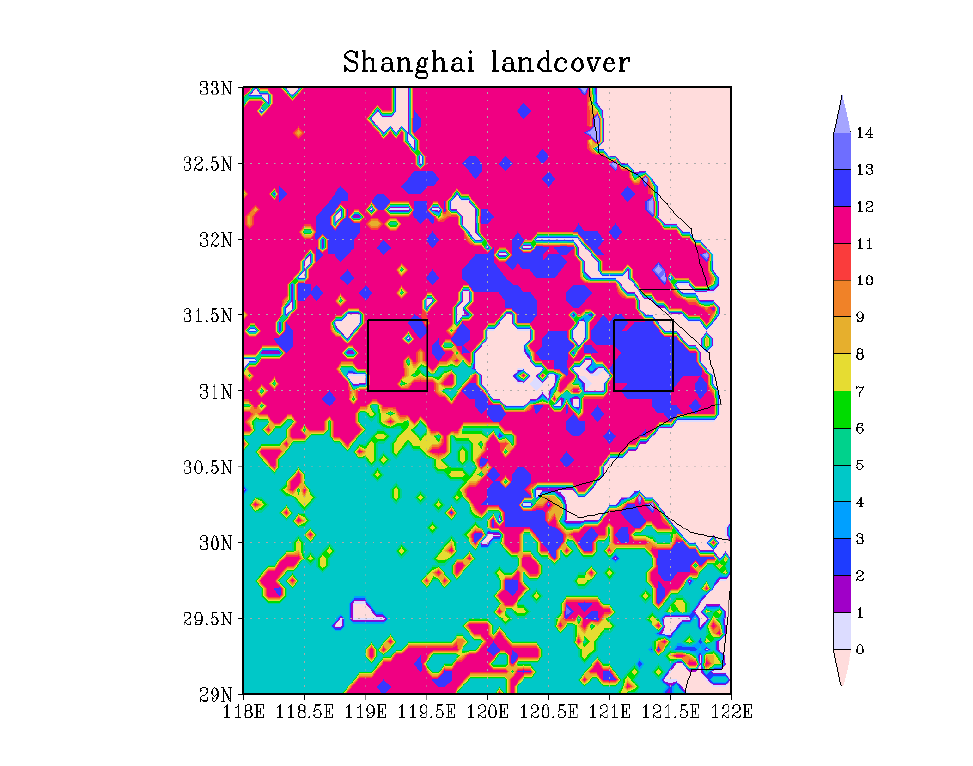
Figure 2. Shanghai Land Cover. The land cover is defined by MODIS as (1).